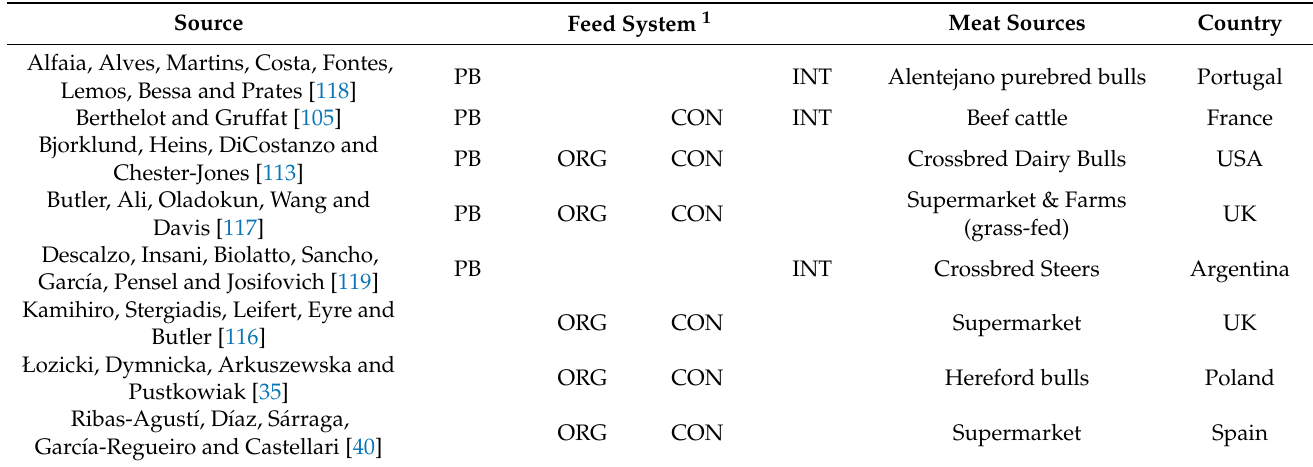
Table 1. Feed system, meat source and country of the seven studies included in the data analysis of fatty acid consumption from